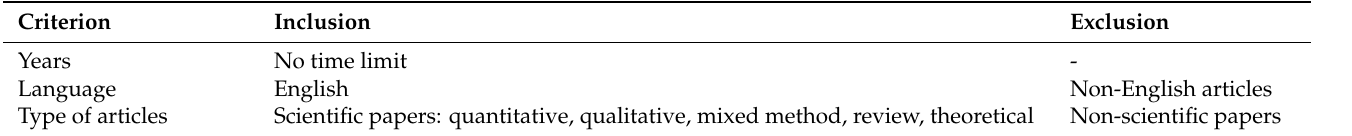
Table 1. Inclusion and exclusion criteria of the search